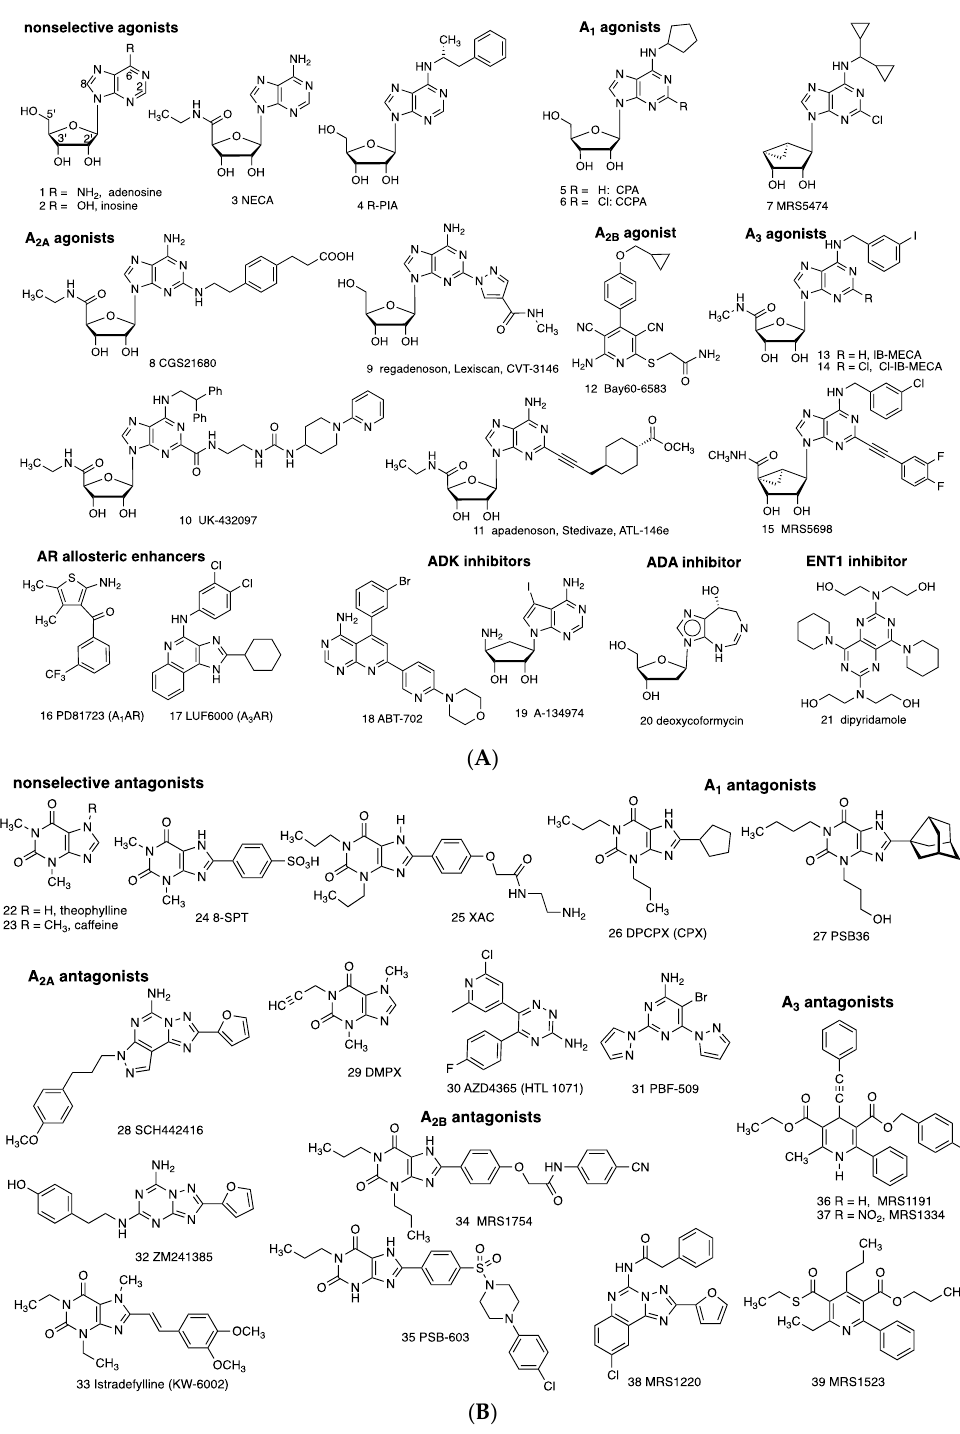
Figure 2. ( A ) Direct (orthosteric agonists 1 – 15 ) and indirect modulators ( 16 – 21 ) of ARs. Compound 2 binds ARs only weakly (> 10 µM), but it activated A 3 AR in vivo [2]. Compounds 1 , 9 , 20 , and 21 are in human use. Compounds 13 and 14 are in clinical trials. Agonists 4 , 10 , and 11 were previously in clinical trials. ( B ) Competitive AR antagonists ( 22 – 39 ). Compounds 22 and 33 are in human use. Compounds 30 and 31 are in clinical trials for cancer.